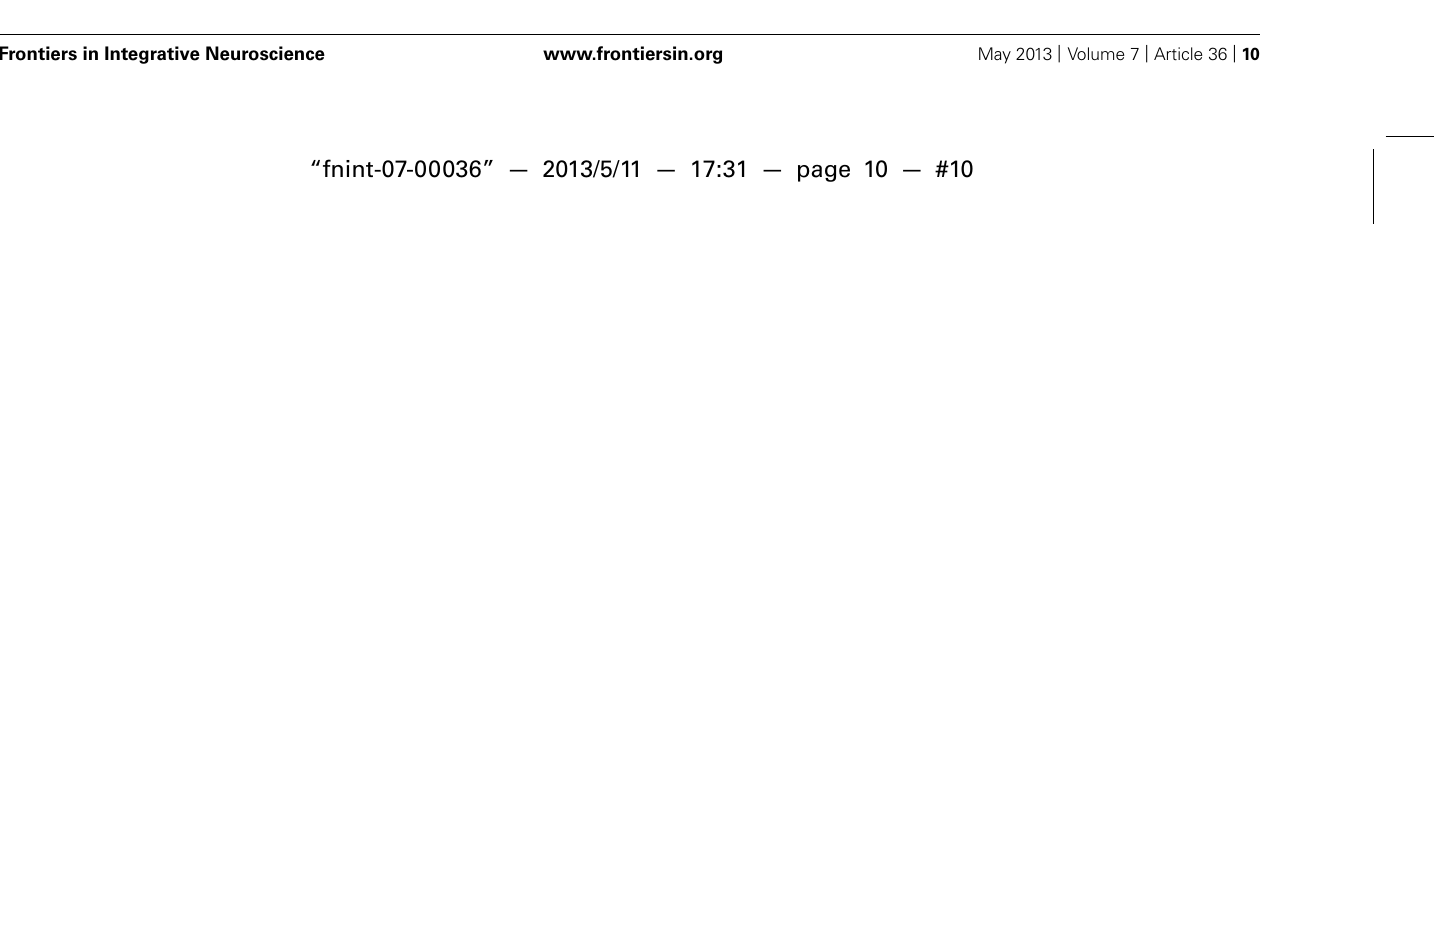
RTit trials.The marker shapes indicate neurons with a significant increase (rightward triangles) and decrease (leftward triangles) in activity during